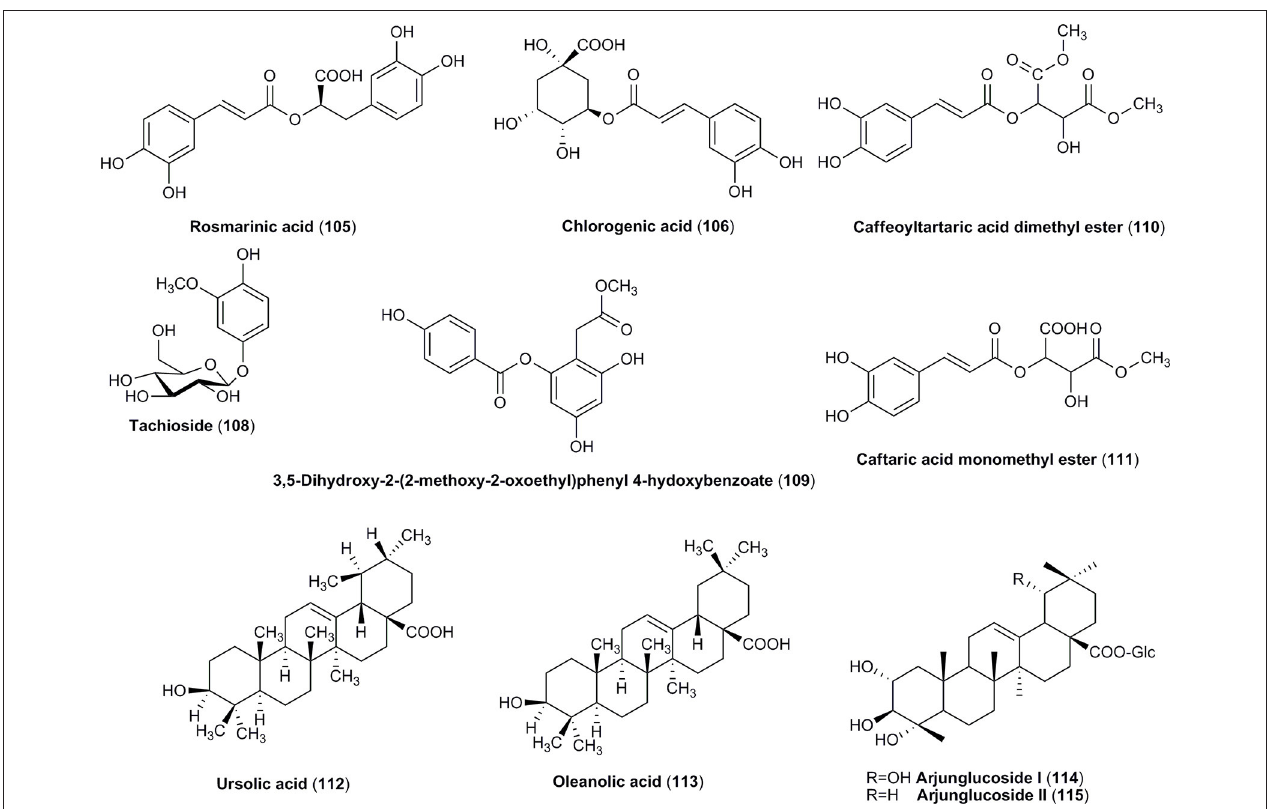
FIGURE 4 | The chemical structures of phenolic compounds and terpenoids identified in fruits of C. mas and/or C. officinalis